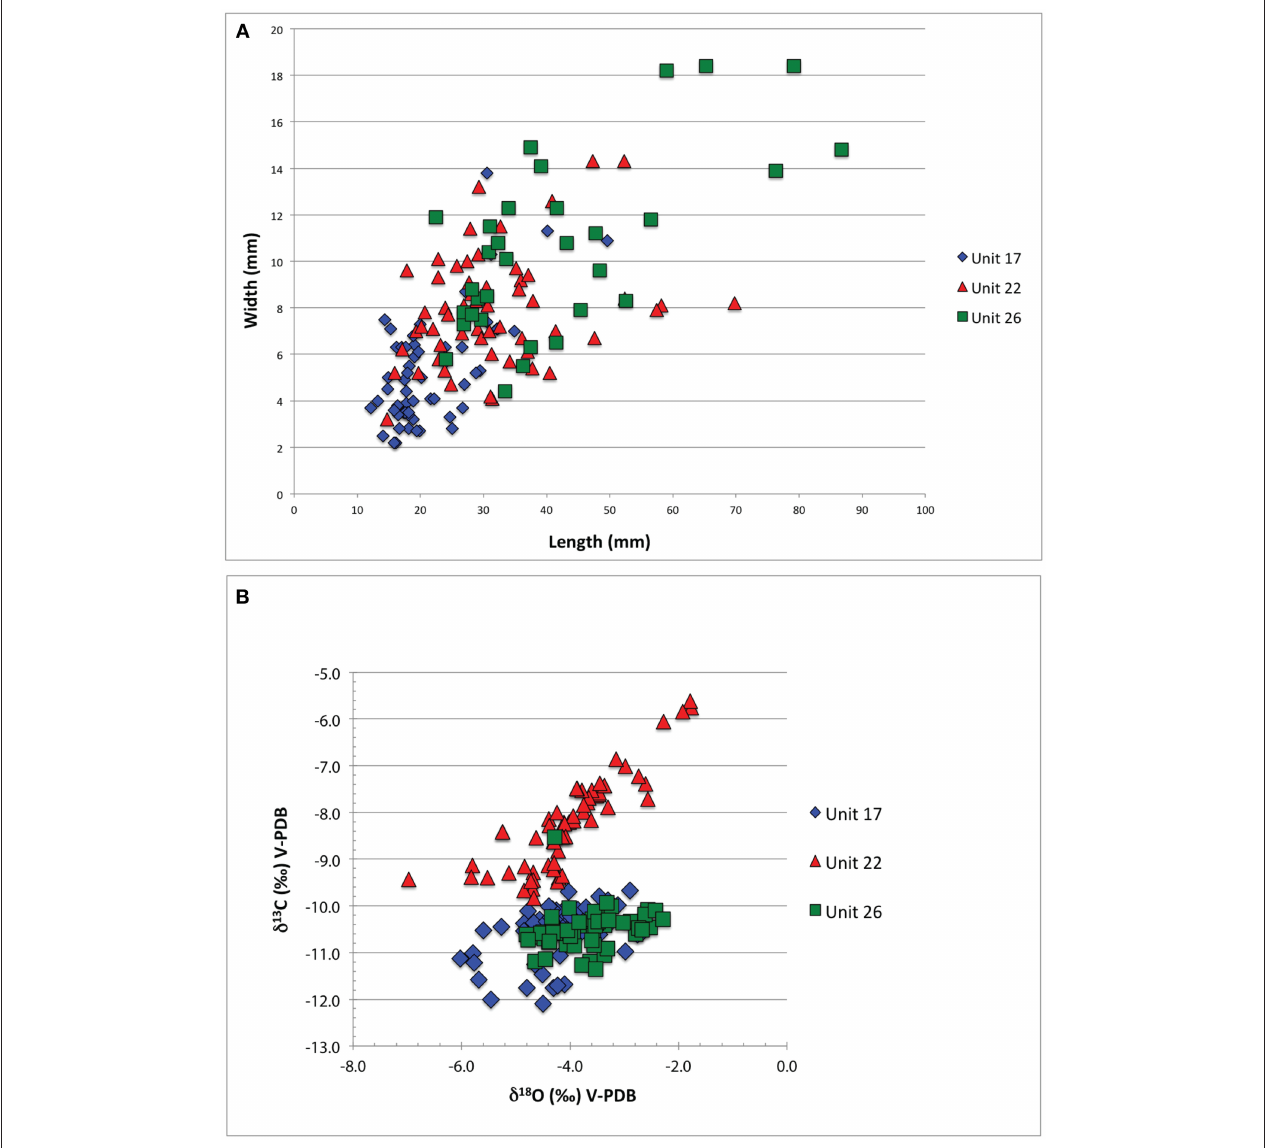
FIGURE 9 | Size and stable isotopic composition data from rhizoliths. (A) Size variation (width vs. length) of rhizoliths collected from Units 17, 22, and 26, immediately overlying rich fossil-bearing strata from LpM4. (B) Comparison of δ 18 O and δ 13 C values ( ‰ , V-PDB) for rhizolith carbonate microsampled from above each fossil-bearing unit. The range in δ 18 O values is similar for samples from all three units, however the average δ 13 C value for Unit 22 unit is significantly higher than that in Units 17 and 26.